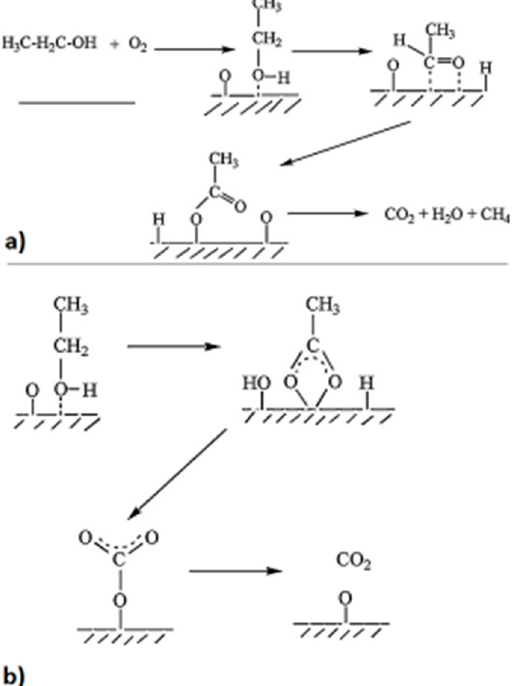
Figure 7. ( a ) Ethanol oxidation mechanism on 0.5 wt% Pt/MCM-41; and ( b ) ethanol oxidation mechanism on 0.5 wt% Pt–15 wt% Co / MCM-41. Figure modified from [114]. Copyright 2012, mechanism on 0.5 wt% Pt–15 wt% Co/MCM-41. Figure modified from [114]. Copyright 2012, Elsevier.